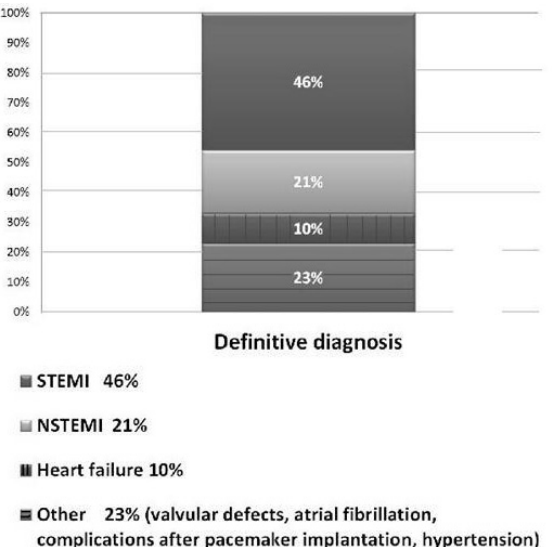
Figure 1. The definitive diagnosis. STEMI - myocardial infarction with ST-segment elevation, NSTEMI - myocardial infarc- tion without ST-segment